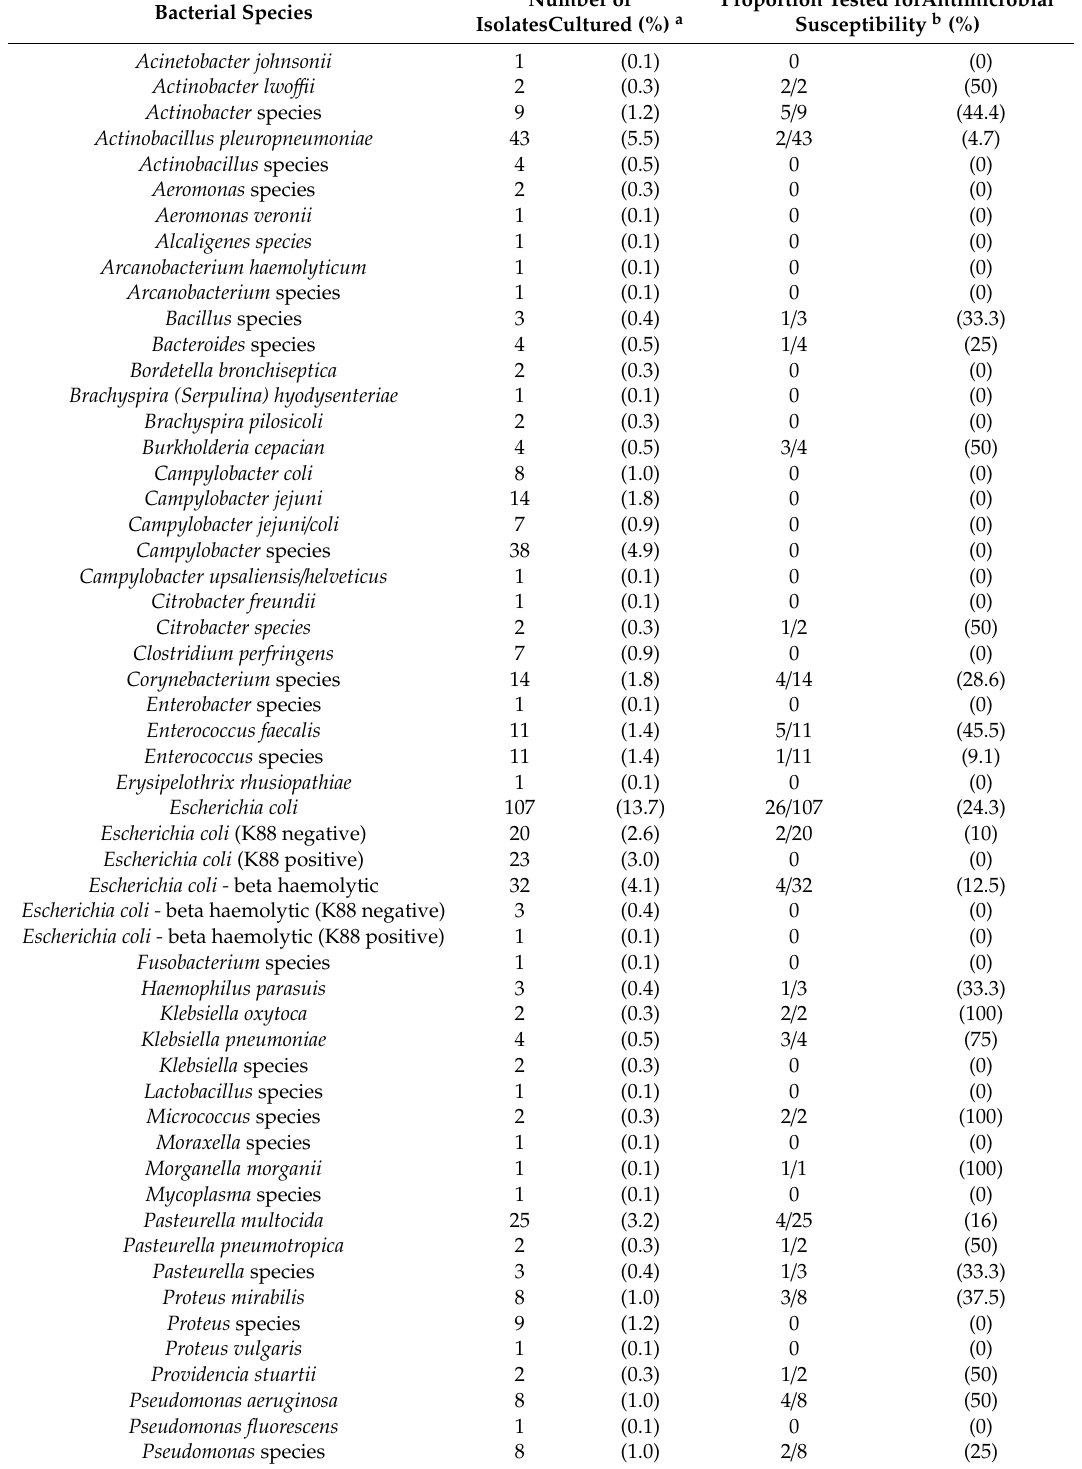
Table 2. Bacterial species cultured from New Zealand porcine samples submissions and proportion tested for antimicrobial